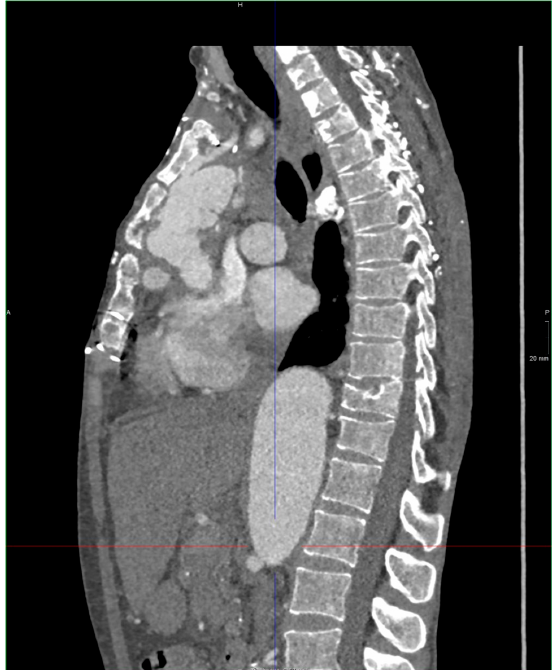
Figure 1. Patient 8. Infected Dacron graft in the ascending aortic position with contained rupture and pseudo-aneurysm formation adherent to the sternum.